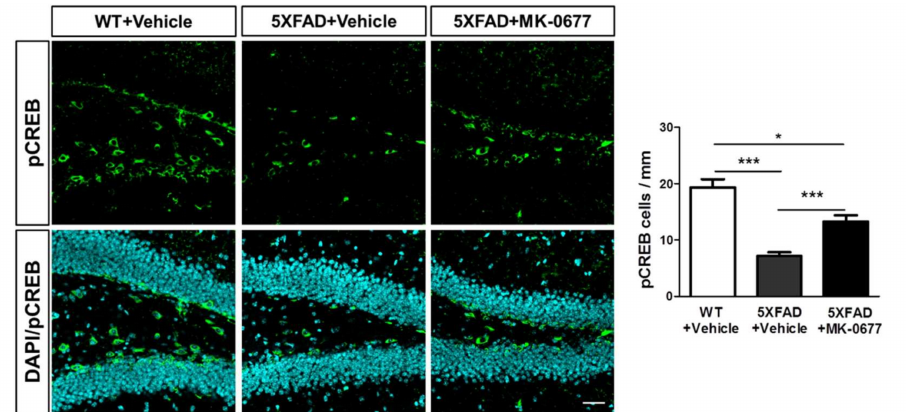
Figure 5. MK-0677 treatment significantly improved the reduced phosphorylation of CREB in 5XFAD mice. Immunofluorescent staining was performed to detect the phosphorylation form of CREB (pCREB) in dentate gyrus of the hippocampus of wild-type ( n = 8) and 5XFAD mice. MK-0677-treated 5XFAD mice ( n = 6) showed significantly increased pCREB, compared with vehicle-treated 5XFAD mice ( n = 7). * p < 0.05 and *** p < 0.001 indicate significant differences between the groups. Scale bar = 50 µ m. CREB = cyclic adenosine monophosphate (cAMP) response element binding